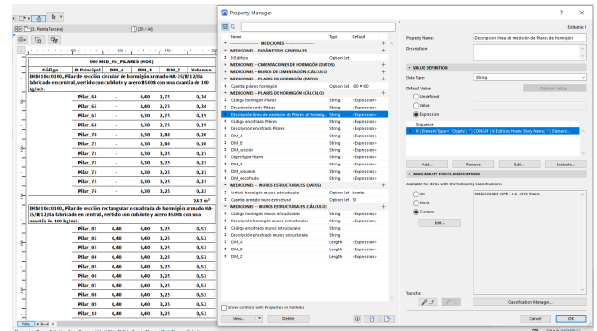
Figure 4. Property Manger